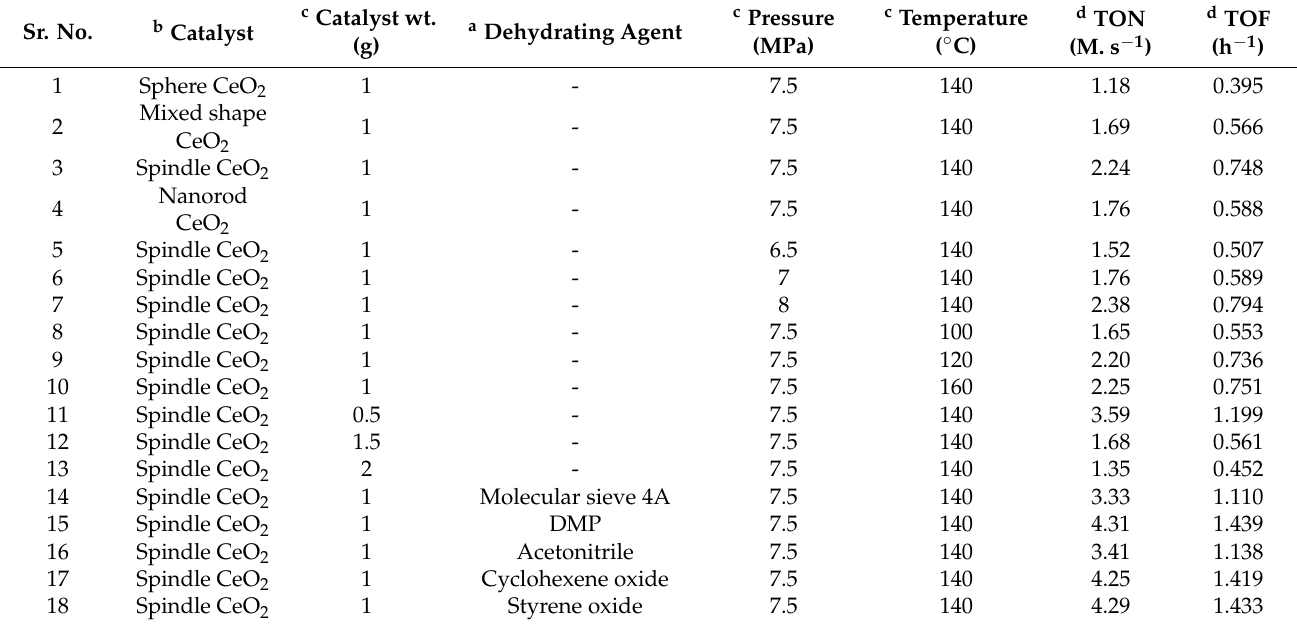
supercritical pressure, i.e., 7.5 MPa seems good for direct conversion of CO 2 and methanol to DMC synthesis. Table 2. Catalytic results for various catalysts and parameters used for DMC synthesis from CO 2 and methanol. Sr.